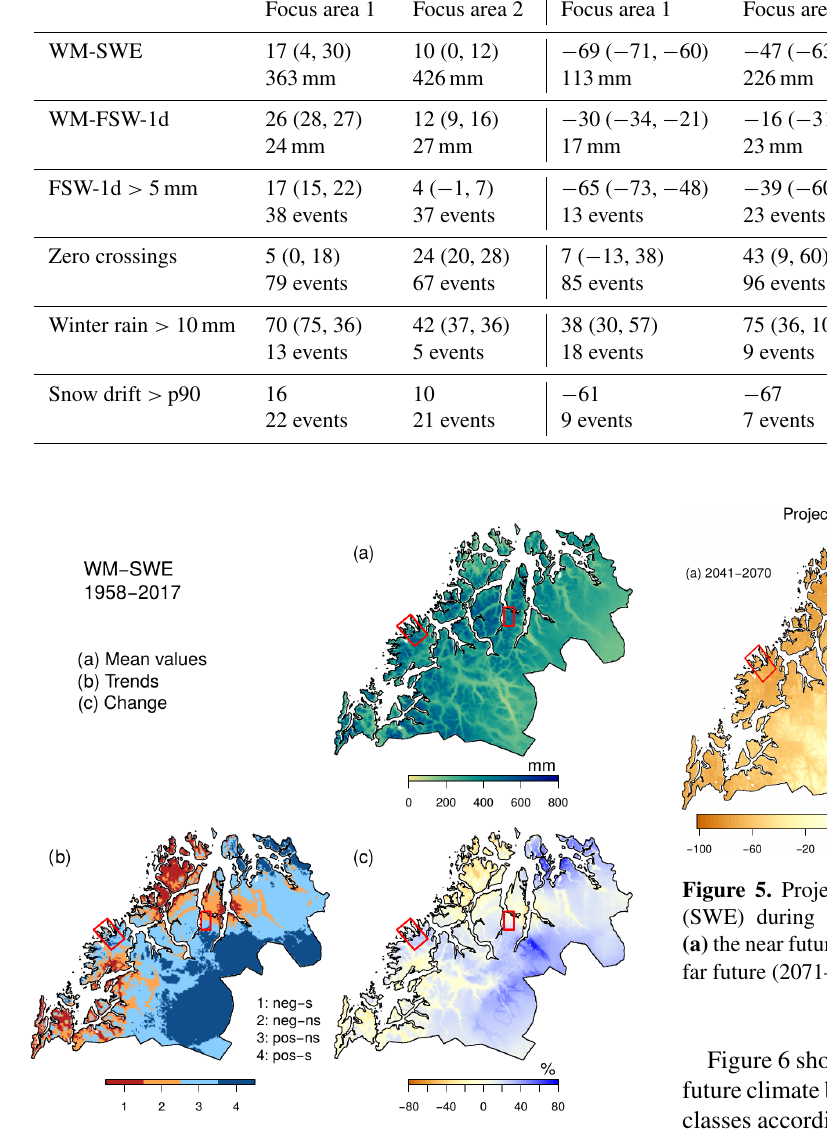
Figure 4. Mean values (a) , trends (b) and changes (c) in winter (October–April) maximum snow water equivalent (SWE) for the period 1958–2017. In panel (b) , positive trends are illustrated in blue and negative trends in red; dark red and blue colours rep- resent statistically negative and positive significant (s) trends, re- spectively. Light colours represent statistically not-significant (ns) trends. In panel (c) , percentage changes between the two 30-year periods 1958–1987 and 1988–2017 are shown.